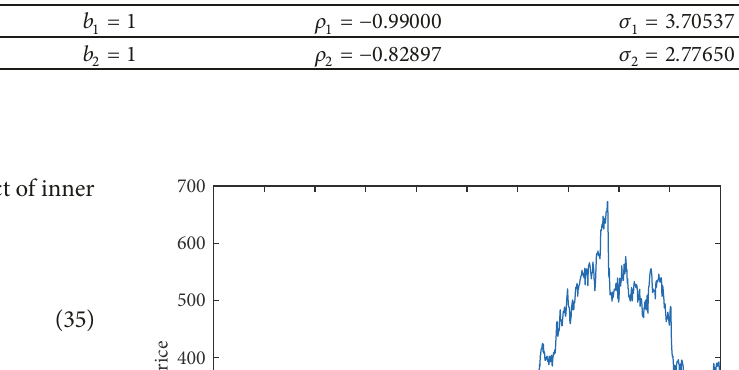
Table 2: Parameters of model.